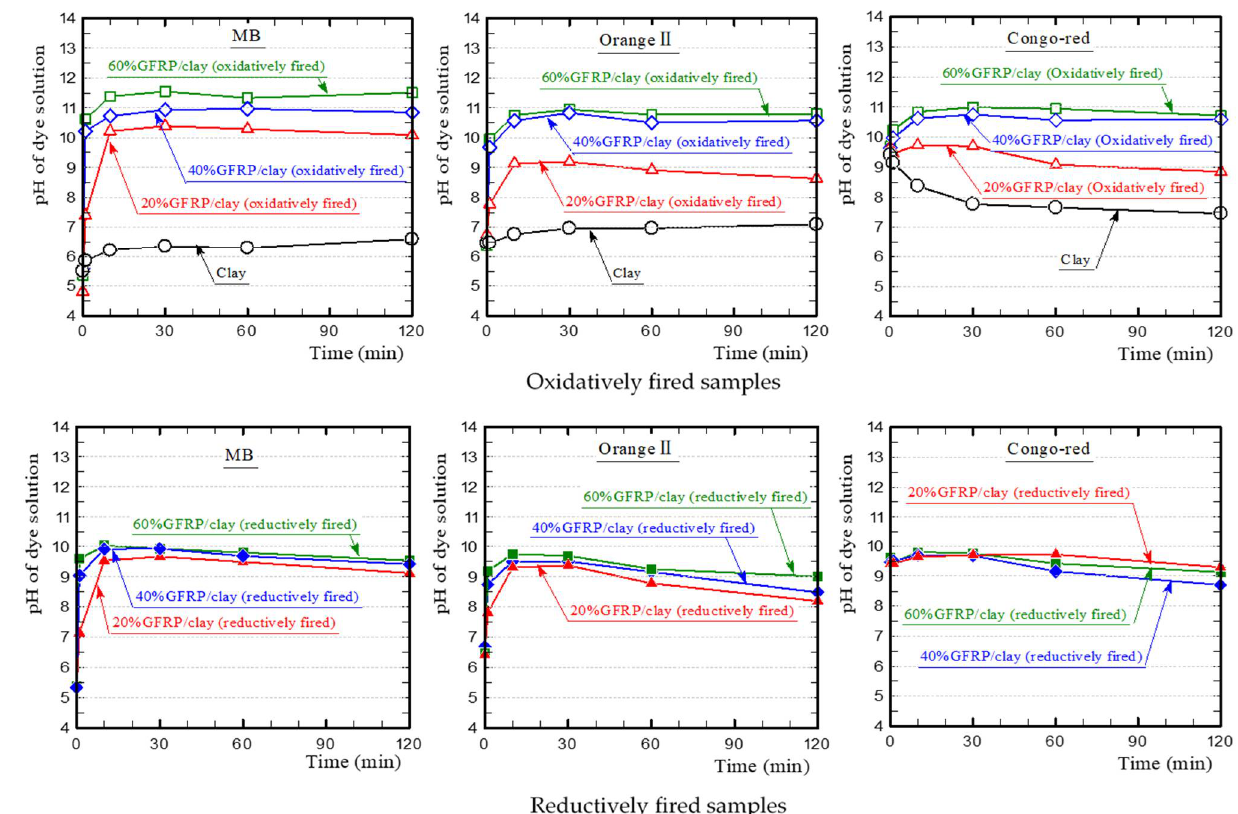
Figure 8. The temporal changes in pH of the dye solutions.